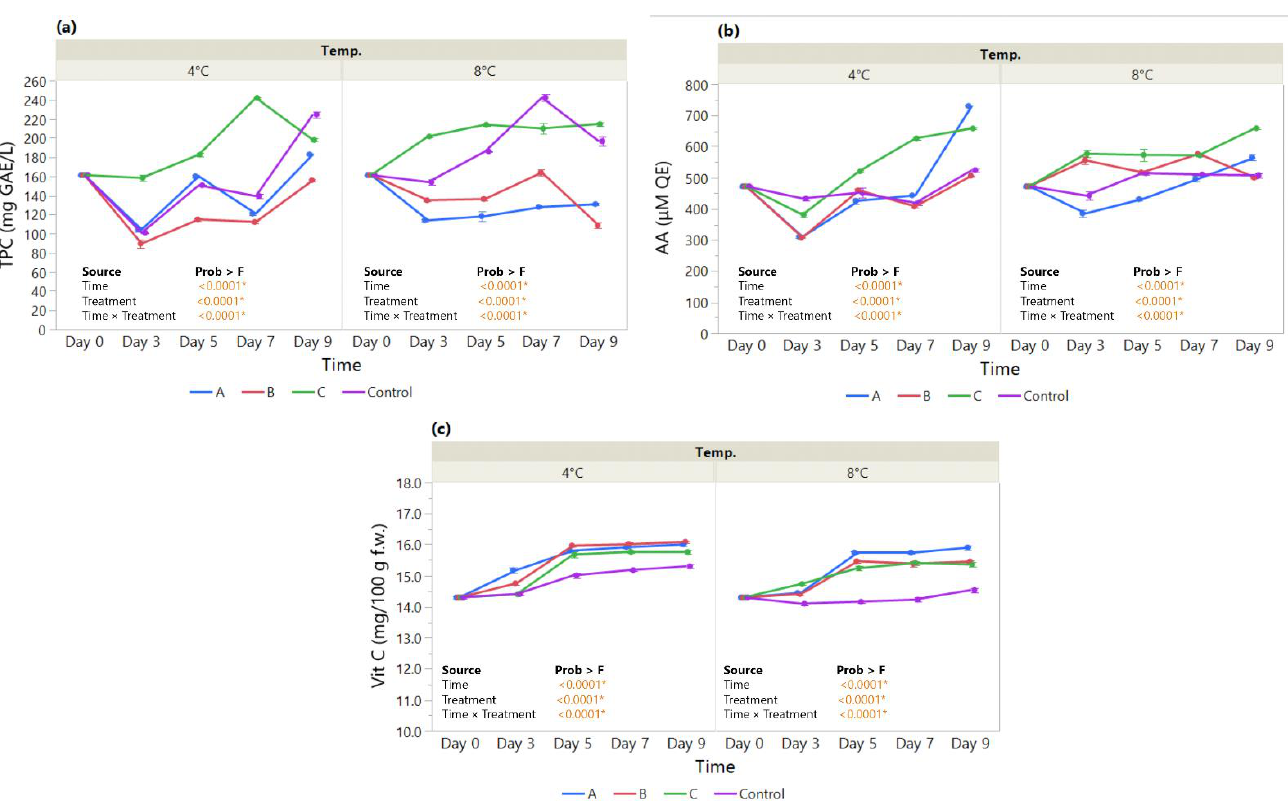
Figure 6. The effect of coating treatment on apple slices antioxidant status during a 9-day storage period at 4 °C and 8 °C. ( a ) Total Polyphenol Content (TPC — mg GAE/L); ( b ) Antioxidant Activity (AA —μM QE); and ( c ) Vitamin C content (Vit C — mg/100 g fresh weight). The p -values for the effects of Treatment (coating), Time and Interaction Treatment × Time are shown. Data are means ± SEM (n = 3). Asterisk (*) indicates significance ( p < 0.05*).